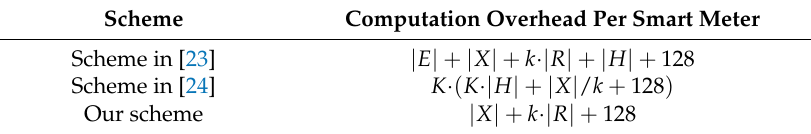
Table 4. Individual spatial communication overhead comparison